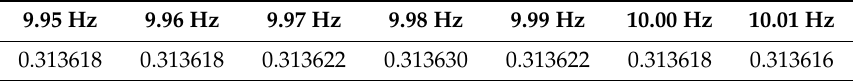
Table 2. The KPE distribution of IMF9 under different driving force frequencies.